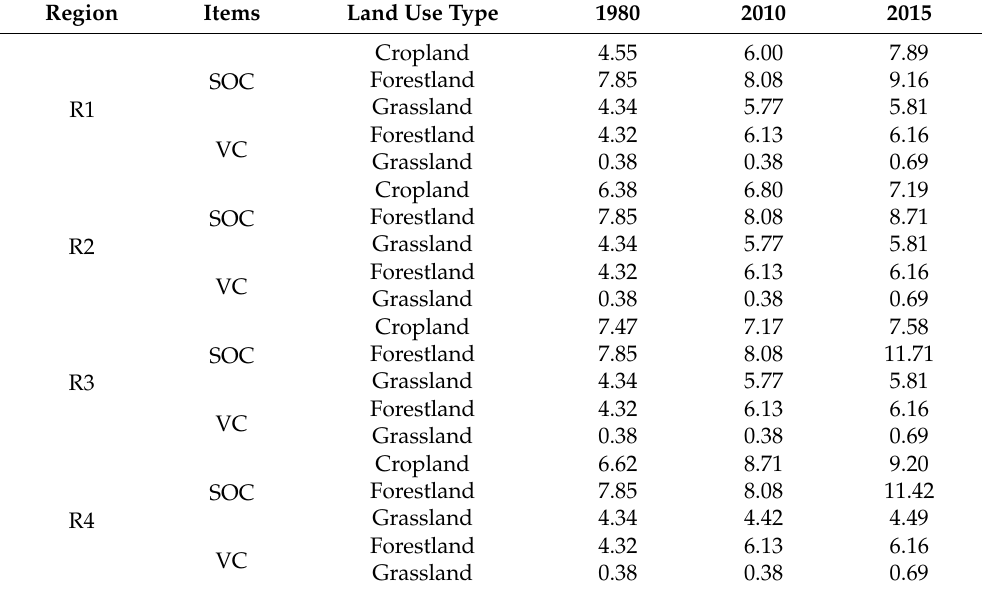
Table 1. Values of SOC and VC in Henan Province in 1980, 2010, and 2015 (unit: kg/m 2 ). Region Items Land Use